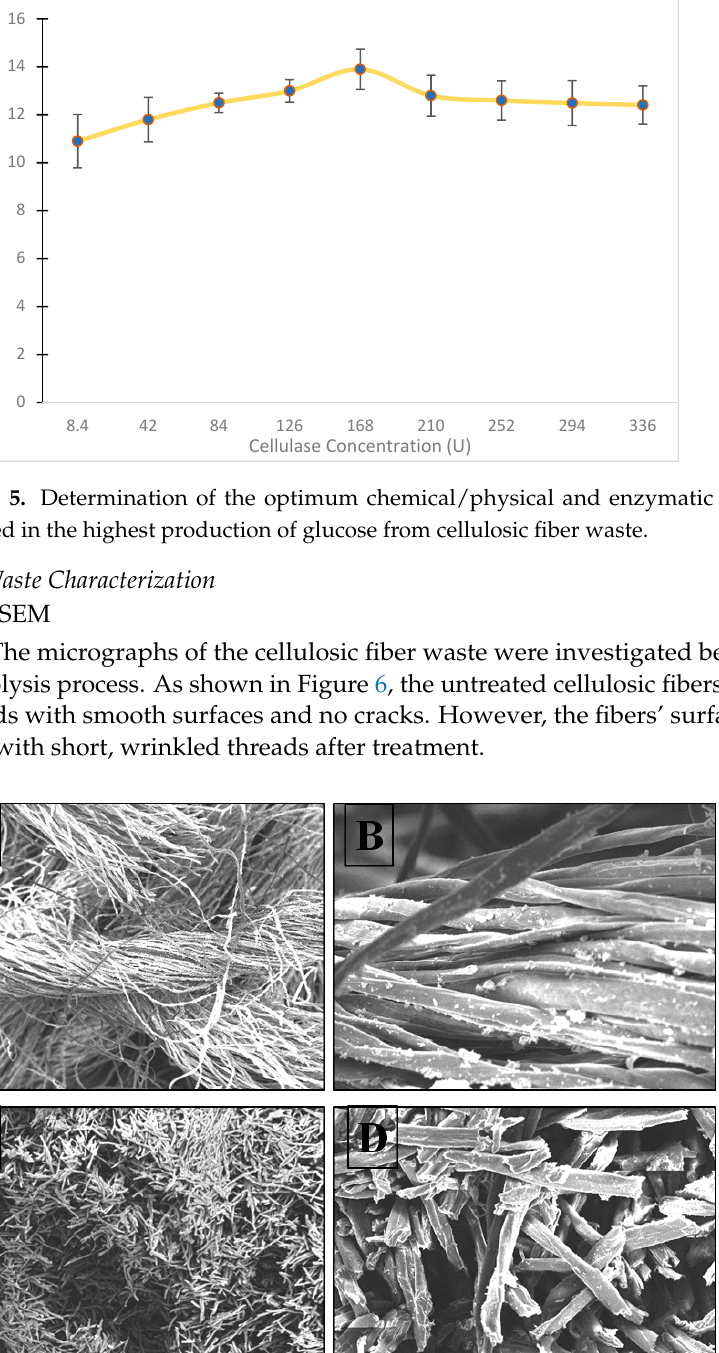
Figure 6. SEM micrographs of the treated and untreated cellulosic fiber waste, ( A ) untreated fiber waste at 200× magnification, ( B ) untreated fiber waste at 300× magnification, ( C ) treated fiber waste at 200× magnification, and ( D ) treated fiber waste at 300× magnification.